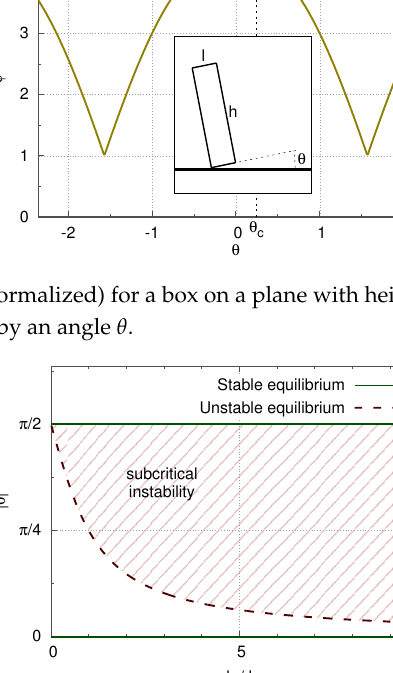
Figure 5. Bifurcation diagram for a box on a plane. The dashed curve is the unstable equilibrium | θ | = tan − 1 ( l / h ) , which corresponds to the threshold amplitude. The region of subcritical instability is shown by hashes; it spans the whole range of finite values of the control parameter h / l